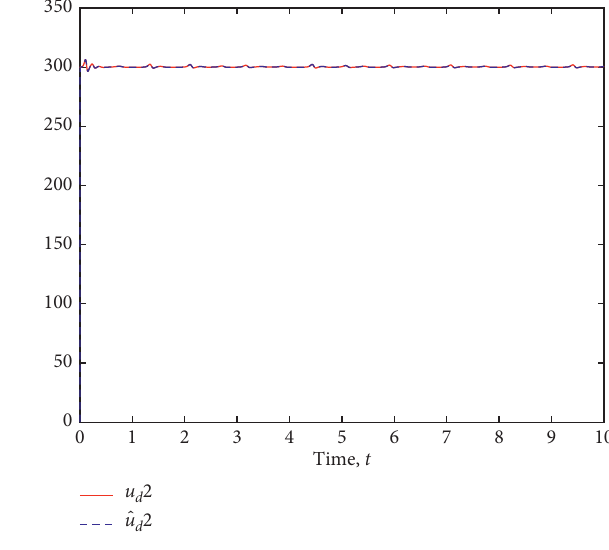
Figure 14: e , e are asymptotically stable. Figure 15: e 3 , e 4 are asymptotically 1 2